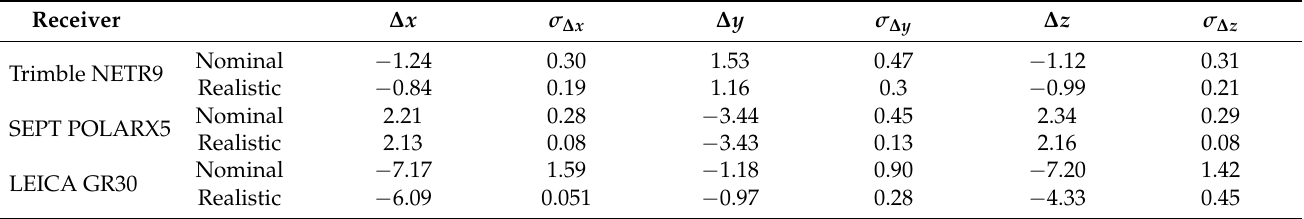
Table 9. The difference between calculated baselines and real values and standard deviations with nominal and realistic stochastic model in multi-GNSS